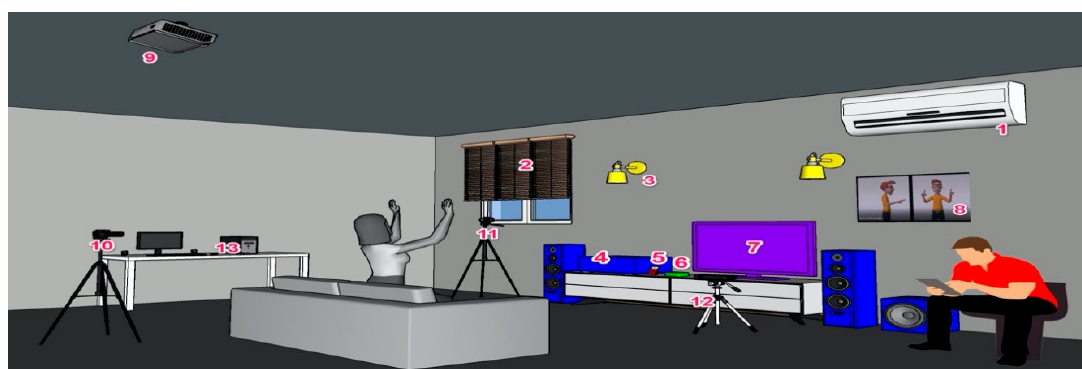
Figure 1. General setup of the experiment that includes: seven devices that the user can control (1–7), a frame displaying help videos on the wall (8), two cameras (10 and 11) for video capturing the experiment, a PC (13) connected to the Kinect sensor (12) and to a projector (9), the researcher that controls the help-videos through an iPad, and the user.